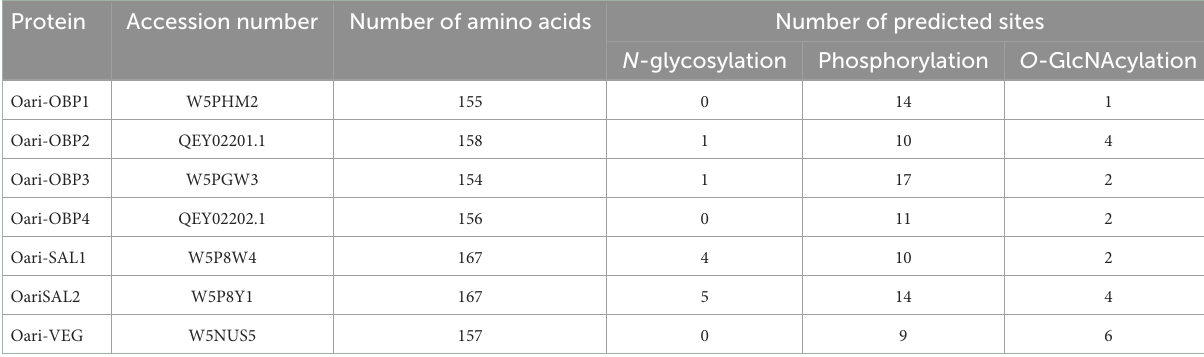
TABLE 2 Number of sites of post-translational modifications predicted for OBPs of ewe olfactory secretome. Protein Accession number Number of amino acids Number of predicted sites N -glycosylation Phosphorylation O